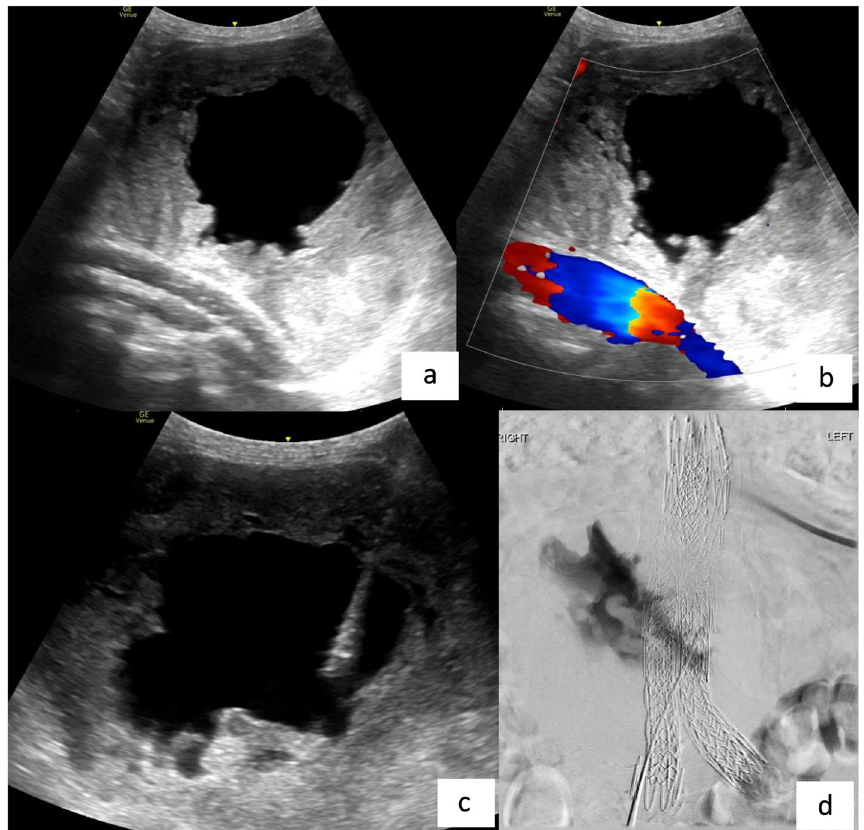
Fig. 1 a —longitudinal view of the aneurysm sac with a central anechoic component surrounded by echogenic thrombus. The components of the Nellix endograft are seen deep to this. b – The endograft is patent with no endoleak identified. c – US guided direct puncture of central anechoic component of the aneurysm sac. d – Contrast injection into the aneurysm sac fills the fluid component without any retrograde flow into the aortic/ iliac branches